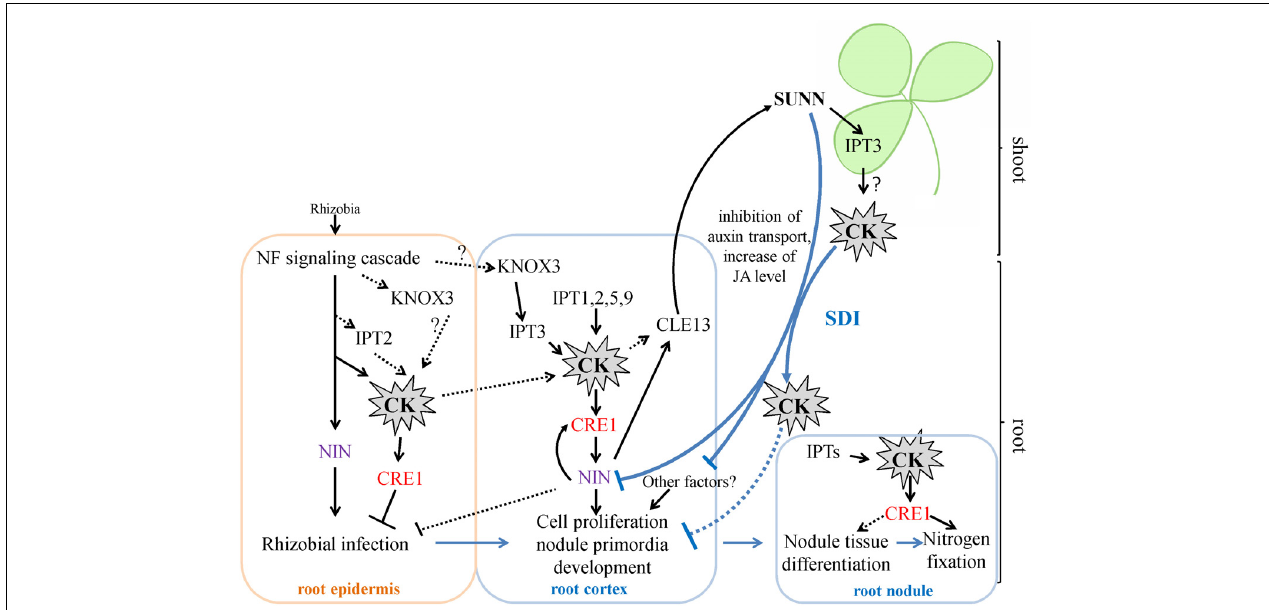
FIGURE 7 | A scheme illustrating the role of IPT s and cytokinin in nodulation in M. truncatula . Cytokinin (CK) biosynthesis and response are activated both in root epidermis and in root cortex in response to rhizobial inoculation. The induction of IPT genes in root epidermis contributes to the negative effect of CK on rhizobial infection, while activation of IPT genes in root cortex is important for cortical cell divisions during nodule primordia development, where CK is known to be a positive regulator. The expression of KNOX3 , a possible activator of cytokinin biosynthesis genes, is induced both in root epidermis and in nodule primordia. CK activates the expression of NIN in the root cortex, where NIN promotes CRE1 expression. The NIN expressed in root cortical cells negatively regulates rhizobial infection. CK are important for nodule tissue differentiation and nodule meristem development, since CRE1 was shown to be important for the transition between meristematic and cell differentiation/elongation zones in indeterminate nodules. Moreover, CK is also important for nitrogen fixation, since it was shown that CRE1 is necessary for this process. The expression of IPT s that was observed at later stages of nodule development in the present study is in agreement with this role of CK in subsequent nodule development and functioning. Being involved in AON, CK induces the CLE13 gene. In its turn, MtCLE13 signal peptide activates SUNN receptor kinase in the shoot, triggering SDI that is transported to the roots where it inhibits subsequent nodulation. CK was shown to be the part of SDI, since in L. japonicus LjIPT3 is activated in the shoot in HAR1-dependent manner, and shoot-derived cytokinin inhibits nodulation. IPT3 activation in SUNN-dependent manner in the shoot is in agreement with these findings. In addition to CK, SDI involves the inhibition of auxin transport and the increase of JA level. SDI has multiple targets in the root, and NIN was shown to be one of them. CK – cytokinin. SDI – shoot-derived